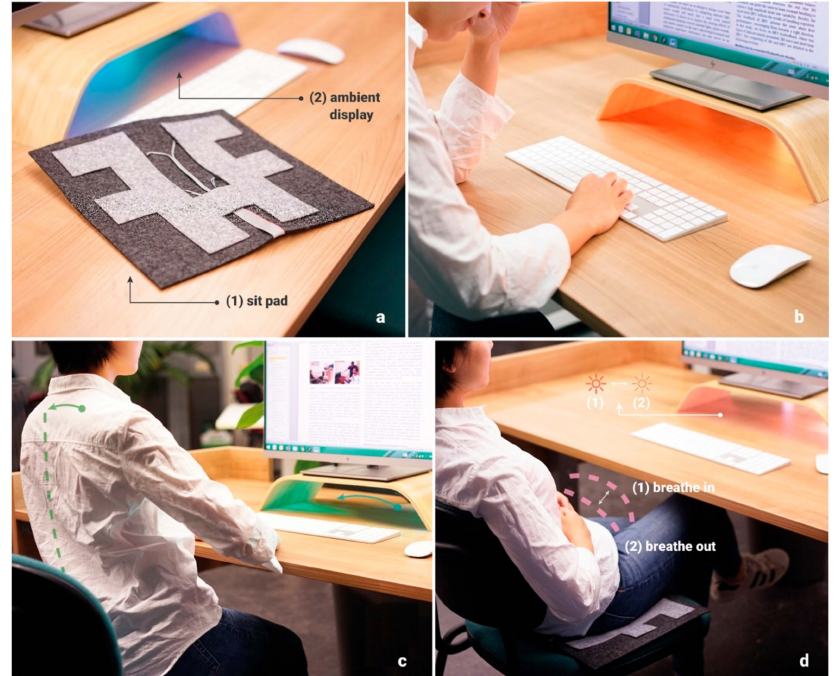
Figure 1. ( a ) LightSit comprises two parts: (1) A sit pad with pressure sensors and (2) an ambient lighting display. ( b ) The peripheral intervention of LightSit: When the user is overstressed and sitting for an extended period, the light becomes brighter and more saturated. ( c ) Stretching fitness: The light waves between left and right to mirror movement. ( d ) Deep breathing relaxation: The light (1) rises and (2) falls to mimic breathing